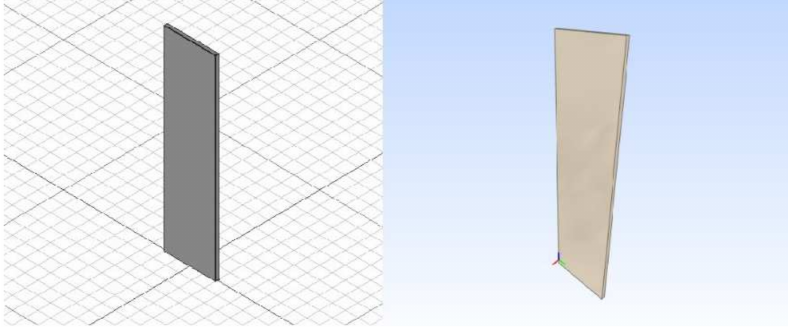
Figure 6. Wall model in FreeCAD and IFC Viewer.